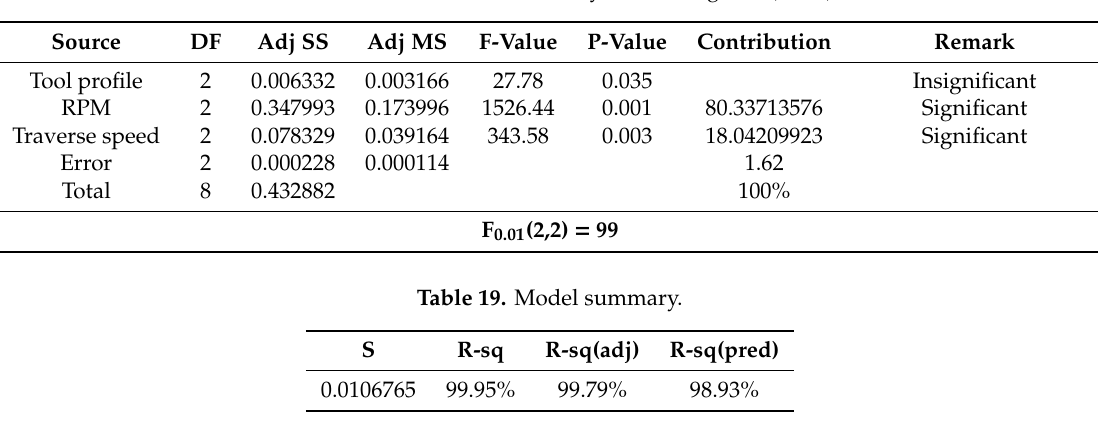
Table 18. ANOVA results for Grey relational grade (GRG).